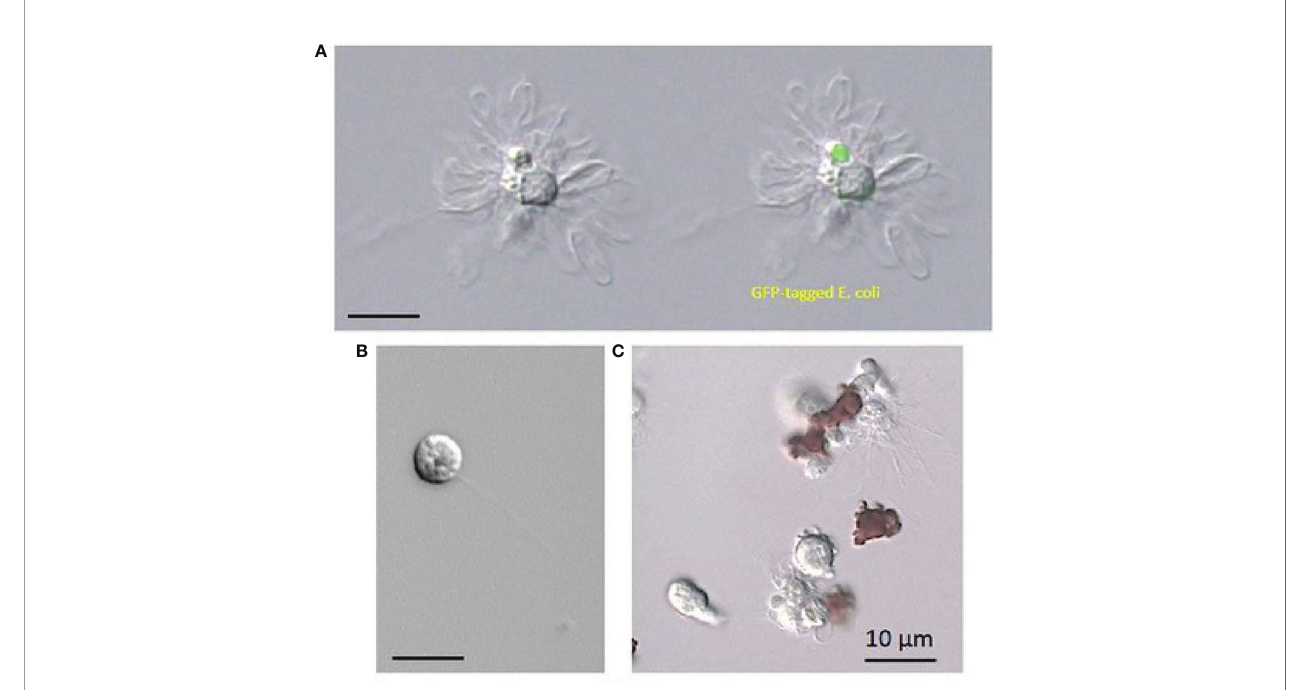
FIGURE 4 | Immune cells from Paracentrotus lividus sea urchin collected as a total cell population in an anticoagulant solution containing EGTA. (A) Phagocytes, (B) vibratile cell, (C) red and white